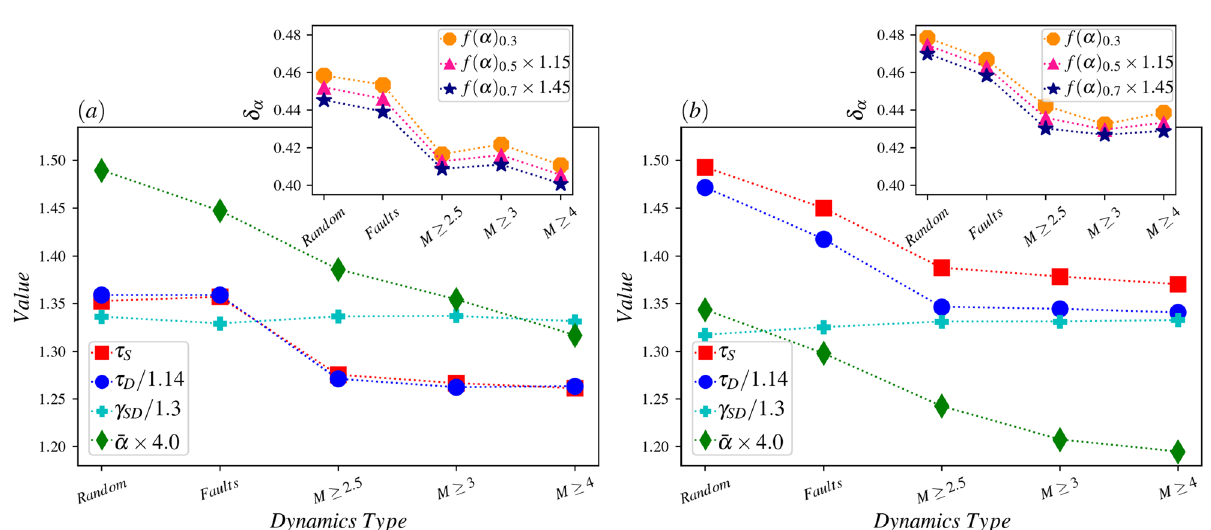
Figure 12. ( a ) Main panel: The value of different exponents vs. dynamics types for the dynamics with avalanches in the whole space. inset: The width of f (α) function in different values against various dynamics types. ( b ) The same for the dynamics with avalanches inside the high-resolution